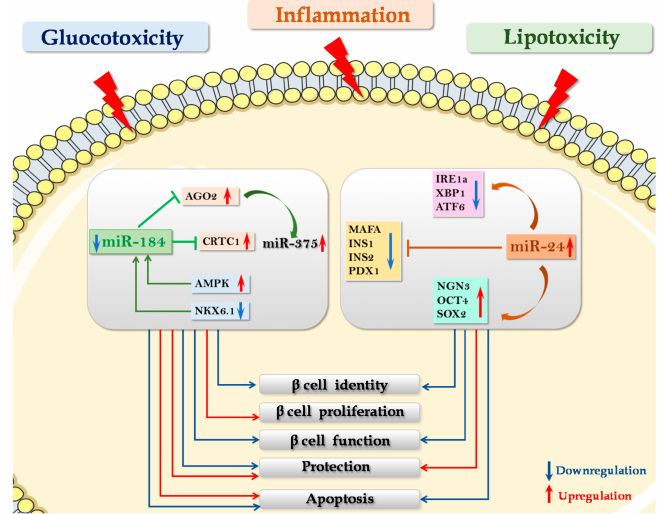
Figure 3. MicroRNAs as regulators of β cell compensation and protection. Metabolic (glucotoxicity and lipotoxicity) and inflammatory stress modulates miR-184, miR-375 and miR-24 expression in β cells. Specifically, miR-184 downregulation induces Ago2 upregulation, leading to expansion of β cell mass. MiR-184-mediated Ago2 upregulation indirectly enhances miR-375 effects on its target genes, which include factors that repress activation of proliferative genes in β cells. miR-184 downregulation leads to enhanced activation of miR-375, which, in turn, activates cell survival and proliferation. Nutrients and factors that modulate AMPK activity (including glucose) can modulate miR-184 expression. Inhibition of miR-184 in human islets increases proliferation and reduces apoptosis following lipotoxic and inflammatory stress. NKX6.1 directly regulates miR-184 promoter; consequently, the reduced expression of NKX6.1 leads to downregulation of miR-184, which in turn causes overexpression of CRTC1 with subsequent β cell protection from apoptosis. MiR-24 upregulation inhibits ER stress-related target genes ( IRE1 α , XBP1 and ATF6 ). Upregulation of miR-24 induces genes typically expressed in dedifferentiated β cells, such as Ngn3 , Oct4 and Sox2 together with a downregulation of Ins1 and Ins2 , MafA , NeuroD1 and Pdx1 , thus leading to the loss of β cell identity and function and to increased protection from apoptosis. The red arrow indicates upregulation/activation, and the blue arrow indicates